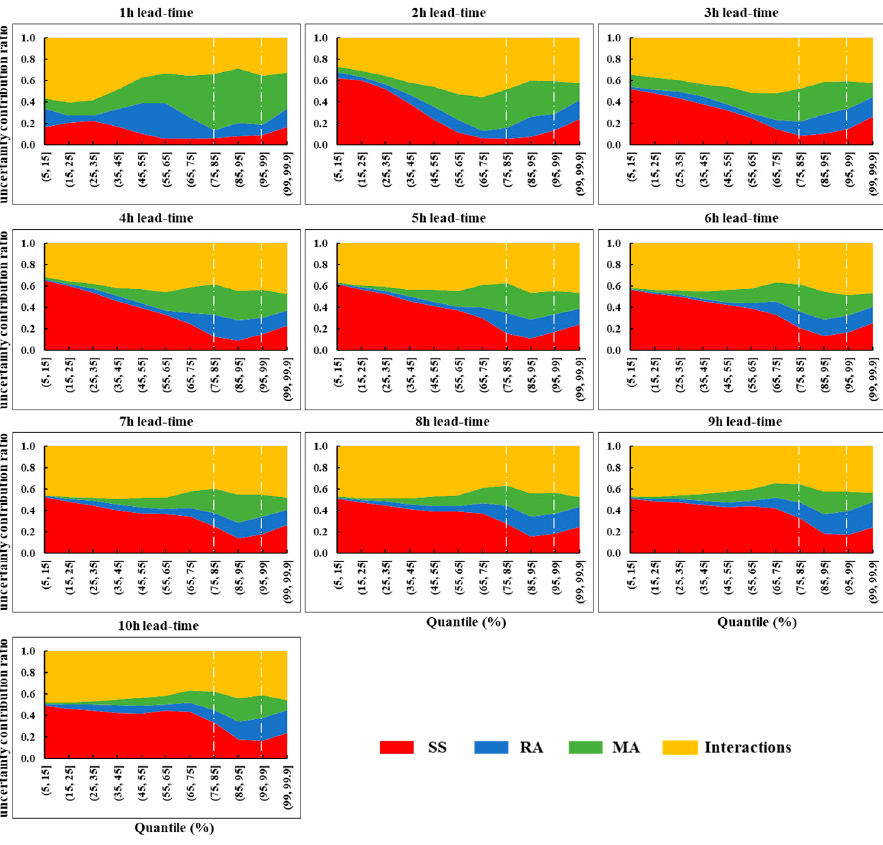
Figure 17. The ratio of the contributions of uncertainty sources in different discharge quantiles.